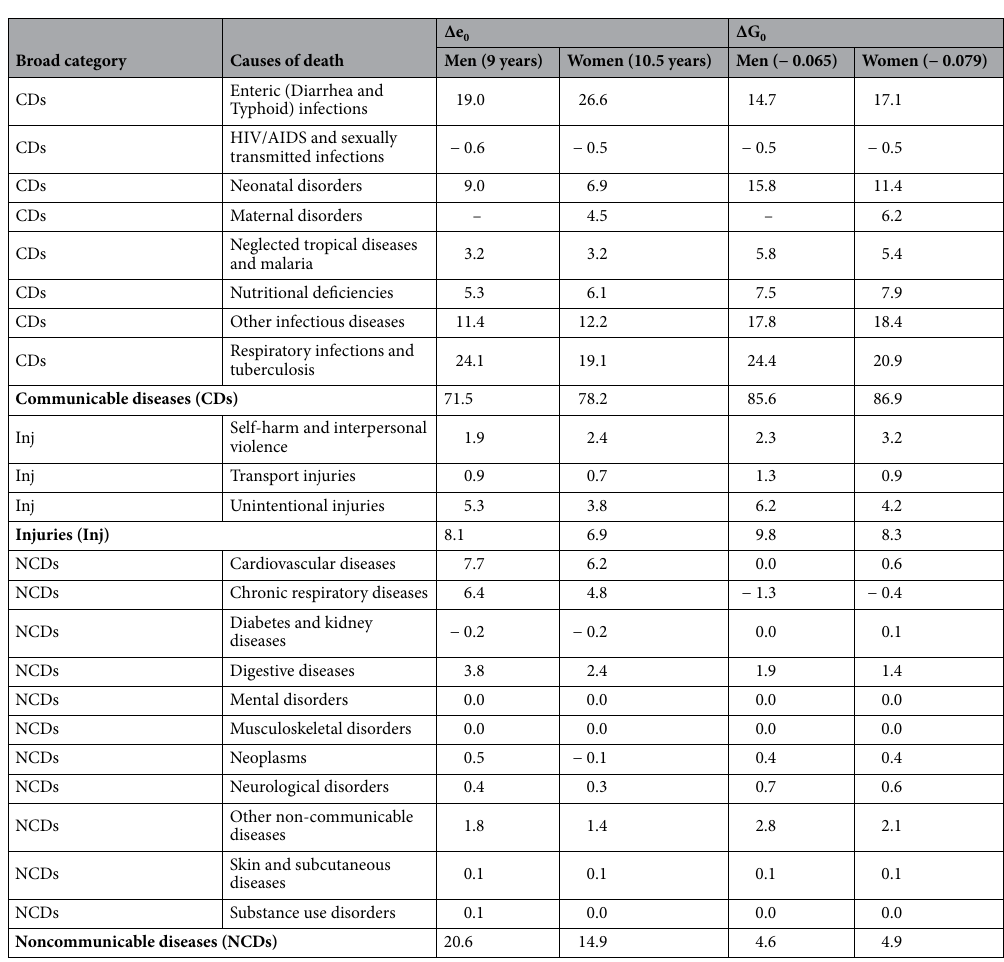
Table 2. Per cent contributions of causes of death to Δe 0 and ΔG 0 , men and women, India, 1990–1994 and 2015–2019. Source: Own